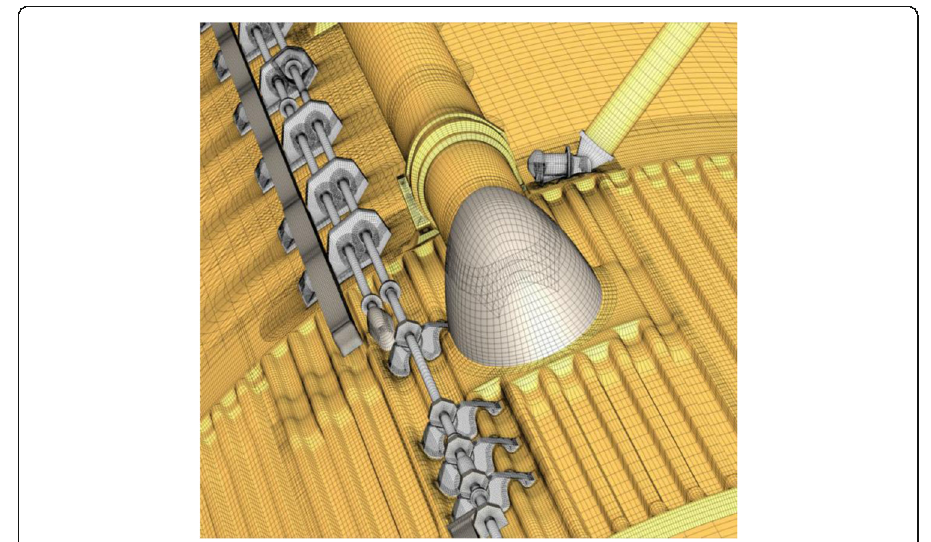
Fig. 9 Required fine-scale geometric details space shuttle external tank [64]